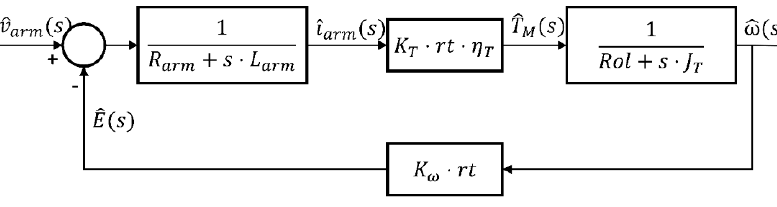
Figure 6. Block diagram of the small-signal model of both DC motor and vehicle.